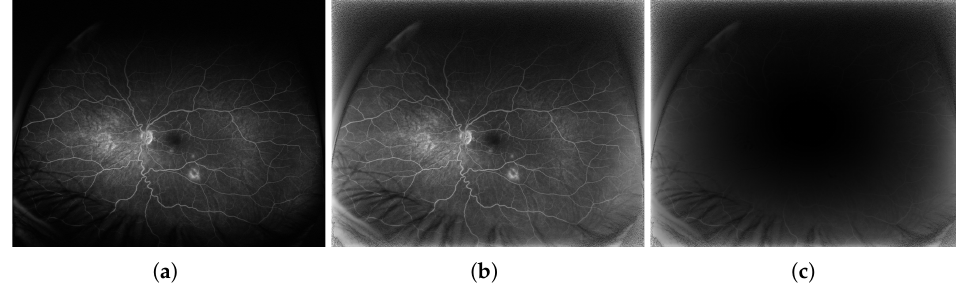
Figure 10. Error distribution for pixel-to-pixel measures: ( a ) exemplary original image, ( b ) contrast enhanced image, ( c ) AE values for each image pixel.